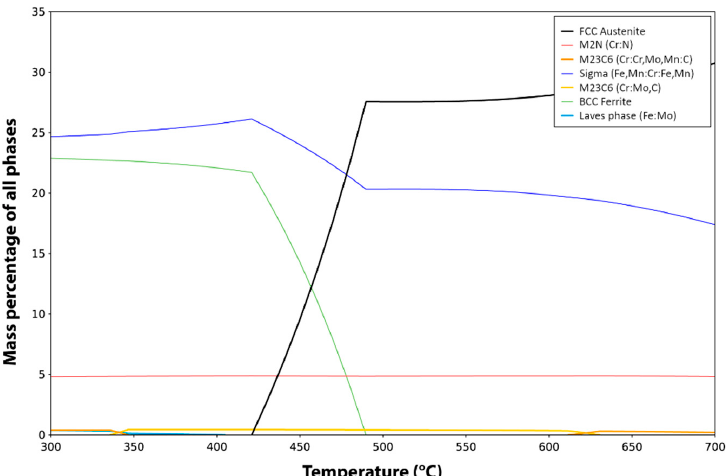
Table 1. Chemical composition, in wt%, of Biodur 108© material.